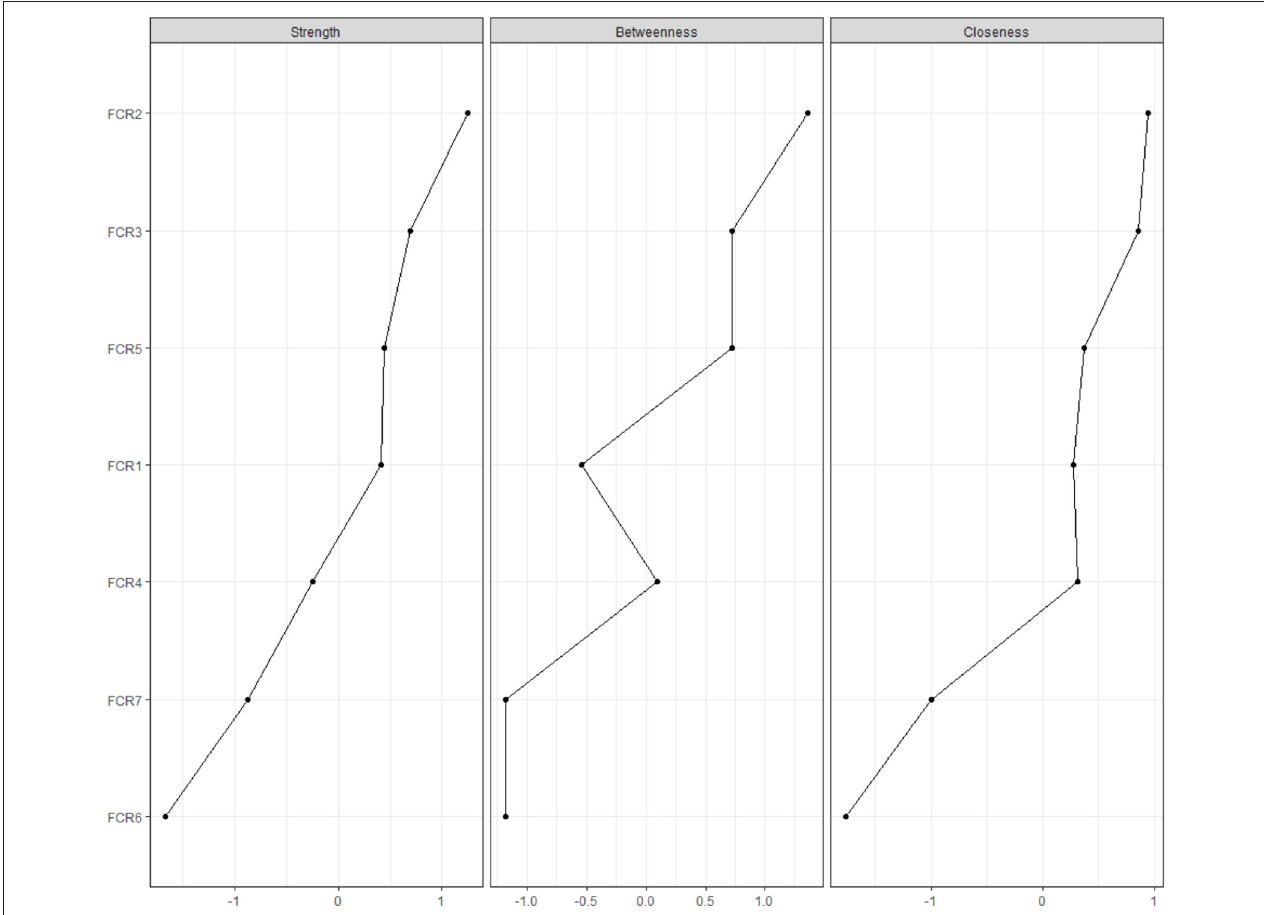
FIGURE 2 | Centrality indices of FCR symptoms. FCR, Fear of Cancer Recurrence.